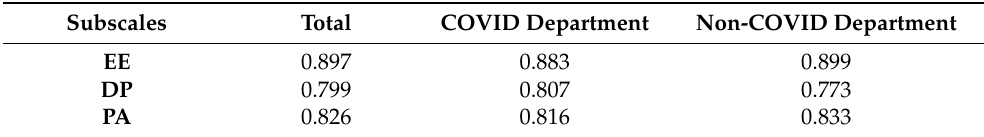
Table 1. Cronbach’s alpha value of MBI and its subscales.